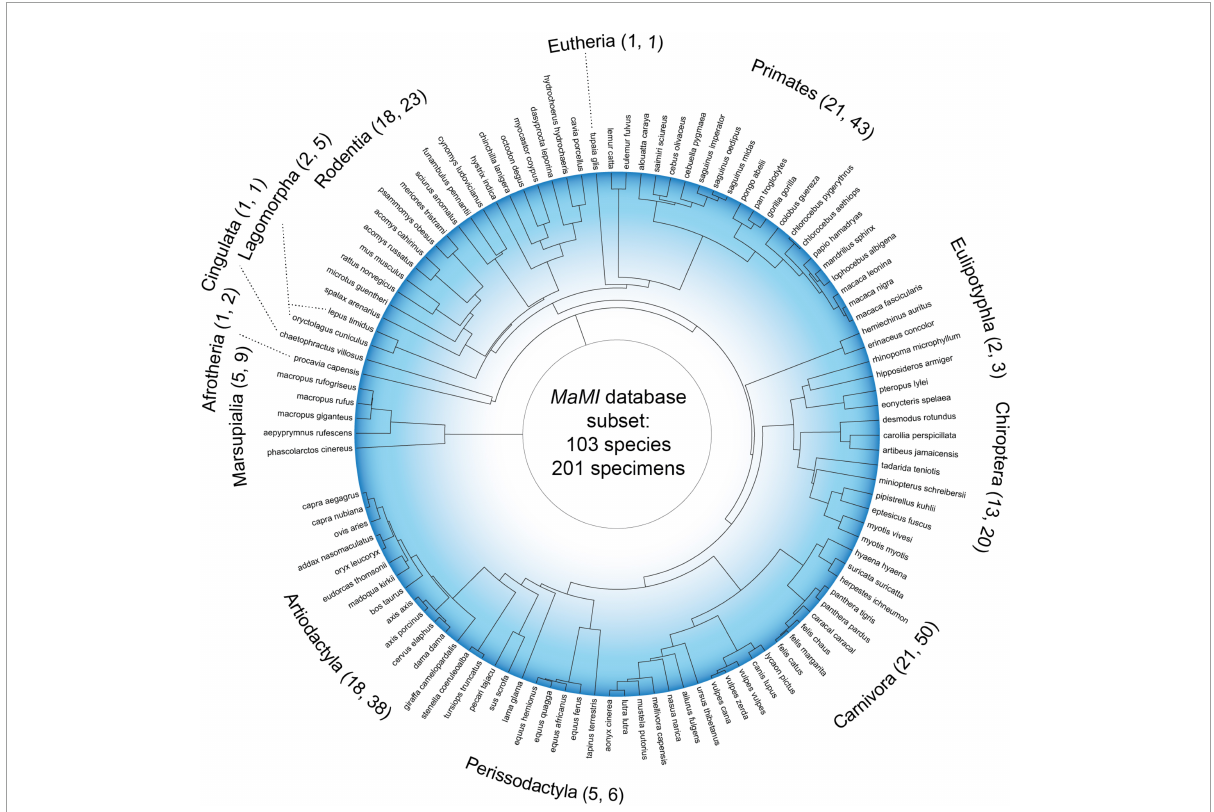
FIGURE1 Phylogenetic tree of the mammals under investigation. Tree distances are derived from a consensus phylogeny estimate (Upham et al., 2019); 103 species names and 12 taxonomic orders are shown. For each taxonomic order label, the first number in parenthesis denotes the number of unique species represented in the underlying tree branch (which sums to 103), whereas the second number denotes the number of specimens for each order (which sums to